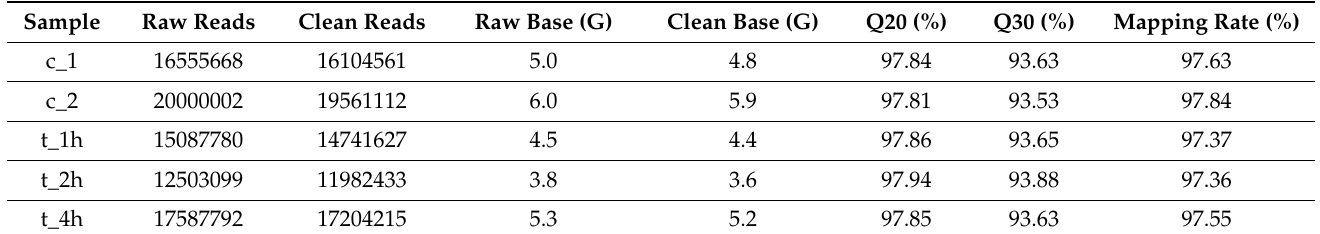
Table 3. Quality statistics of clean sequencing data. Q20 and Q30 refer to the proportion of base calls with Phred scores > 20 or 30 in the total bases. Higher scores ensured the base-calling accuracy and data quality. The sample before treatment has two biological replicates. The c_1 and c_2 are before HPCD treatment; t_1h is after 1 h HPCD treatment; t_2h is after 2 h of HPCD treatment; and t_4h is after 4 h HPCD